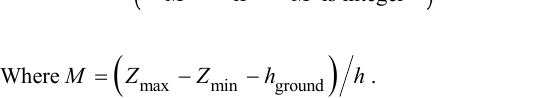
Figure 2. 2D gridding of input MLS data